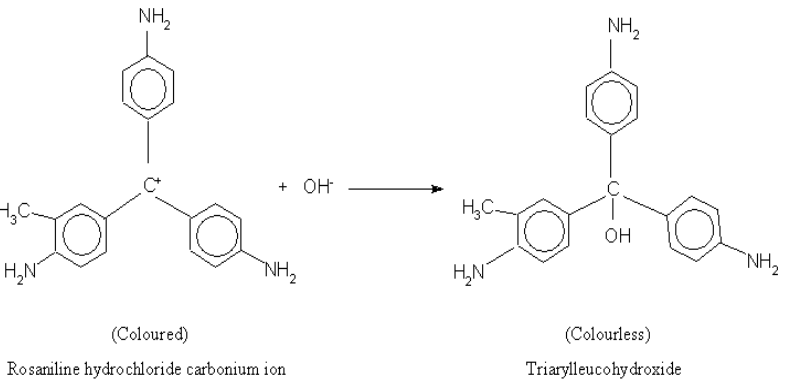
Figure 1 Reaction of Rosaniline hydrochloride carbonium ion with OH -